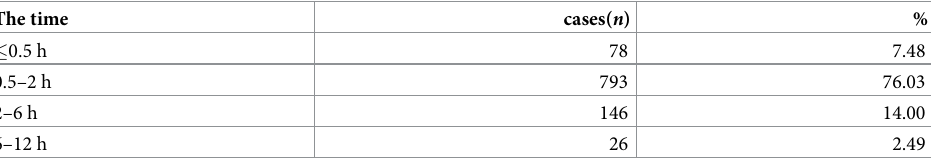
Table 3. The time from application for teleconsultation to completed consultation (n = 1043). The time cases( n ) % � 0.5